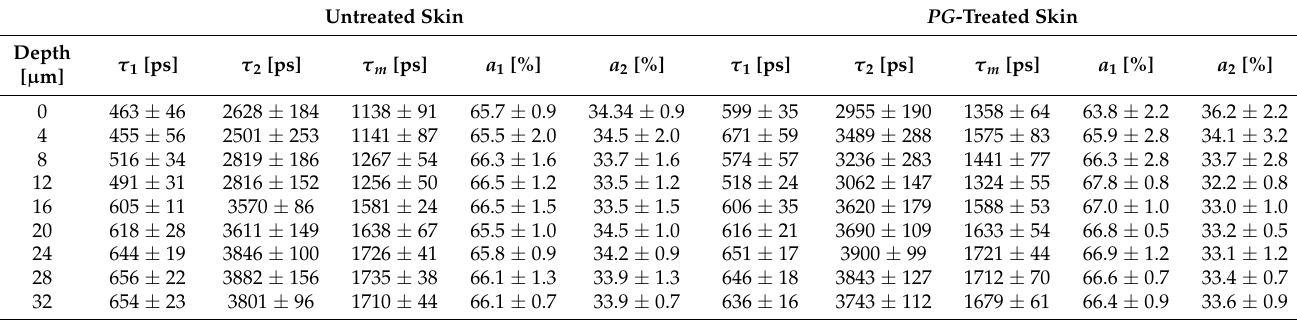
Table 2. TPE-FLIM parameters of untreated and PG -treated skin. Mean ± SEM. N = 6. Untreated Skin PG -Treated Skin